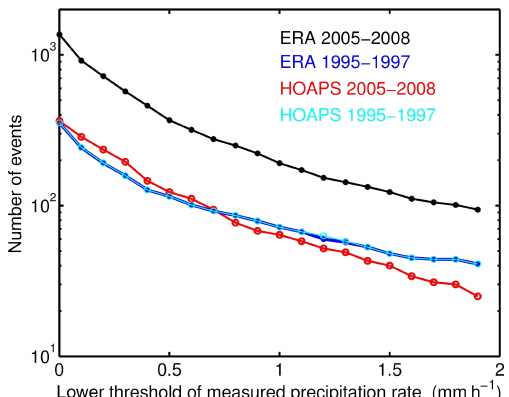
Figure 6. Number of events with measured precipitation, where the precipitation rates exceed the given lower